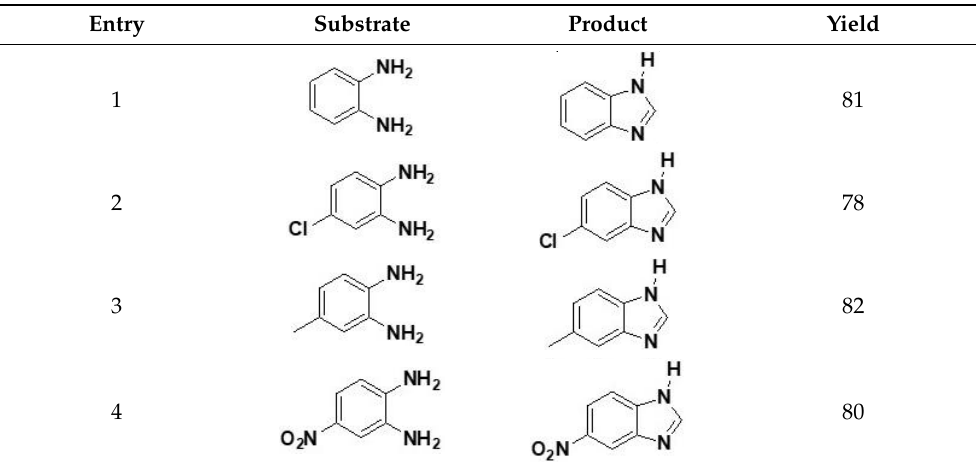
a Reaction conditions: substrates, 1.0 mmol; temperature, 115° C; pressure, 30 bar; time, 18 h.